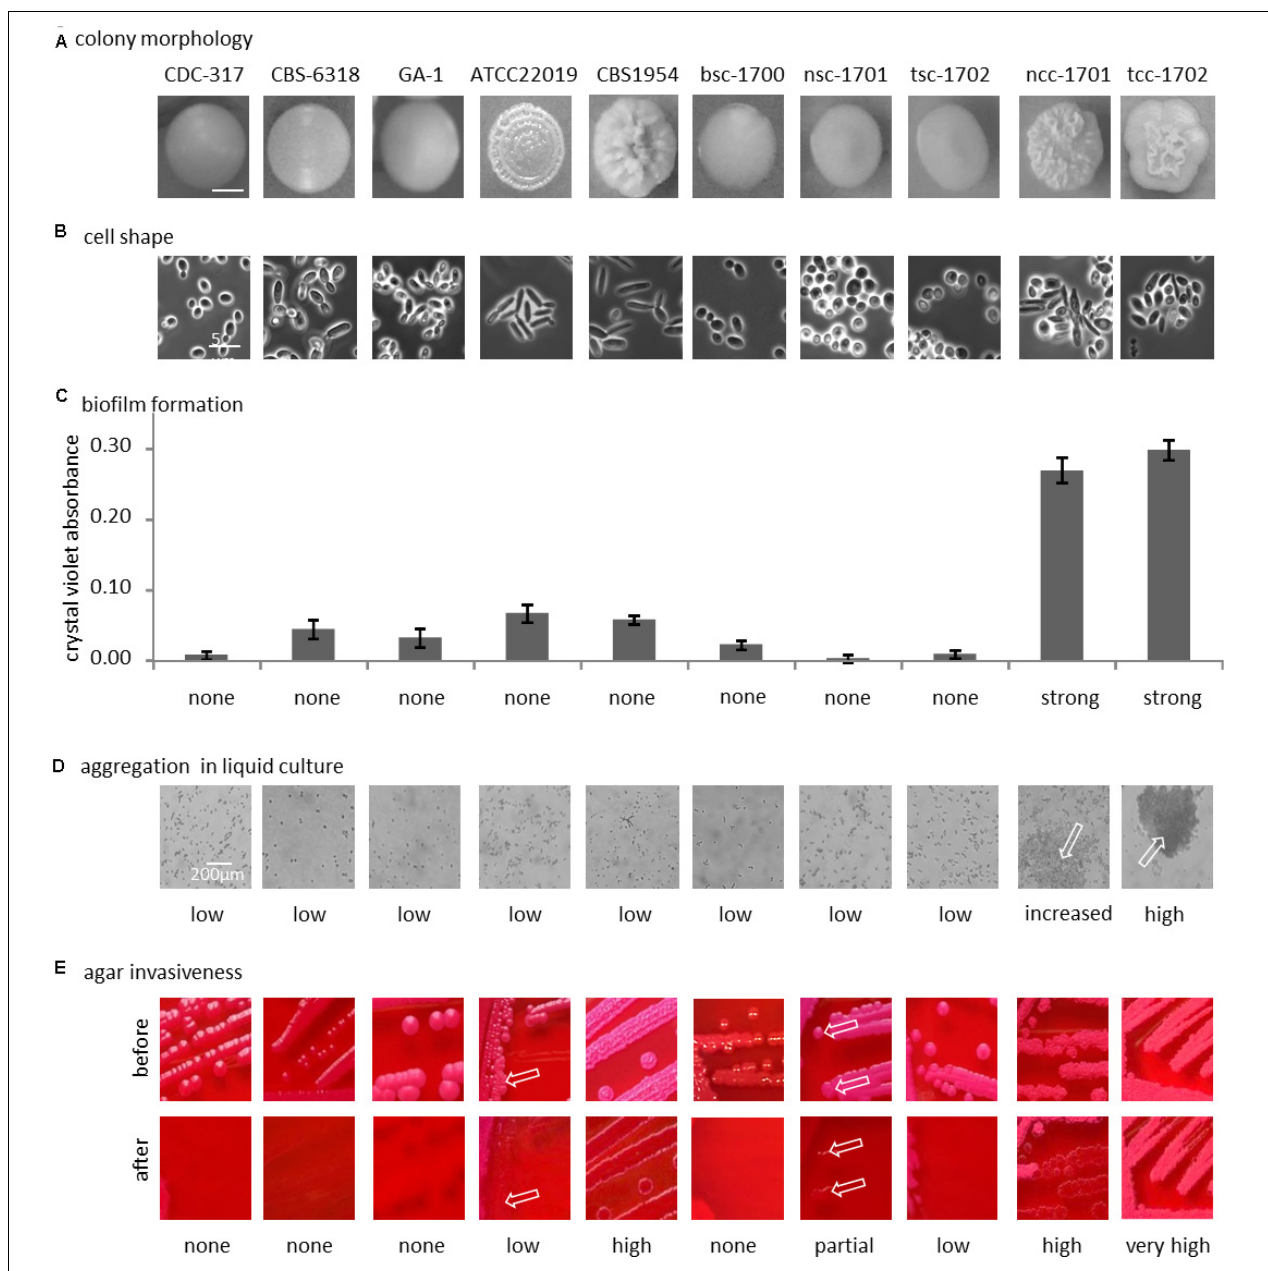
FIGURE 2 | Phenotypical differences. (A) Colony morphology on phloxine B agar; bottom row, cellular shape (100-fold magnification, phase contrast). (B) Representative morphology of the colony used below in panels (C–E) . (C) Biofilm formation on polystyrene. (D) Clumping of cells in liquid culture (optical microscopy, 40x magnification), arrows indicate clumps. (E) Agar invasion, arrows indicate small localized sites of agar invasion in otherwise non-invasive strain. See text for